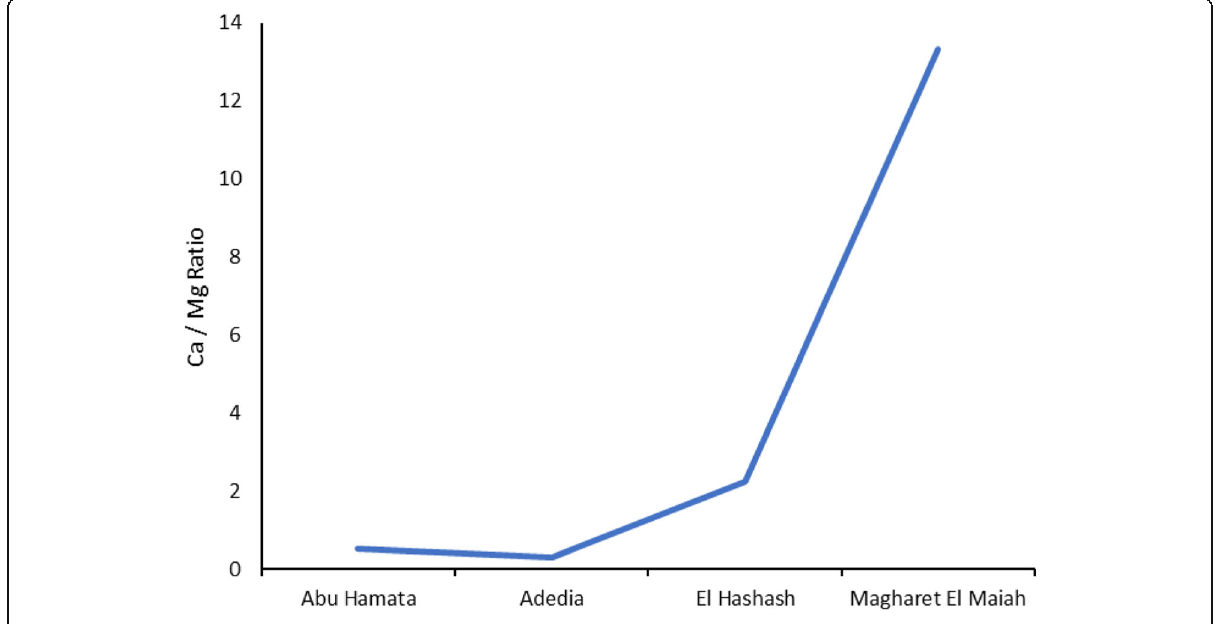
Fig. 8 Ca/Mg ratio of the studied Paleozoic mudrocks